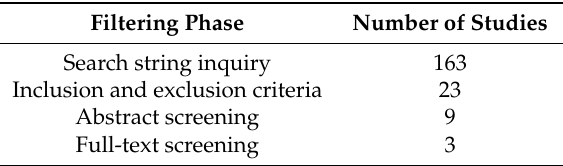
Table 2. Study selection for the systematic